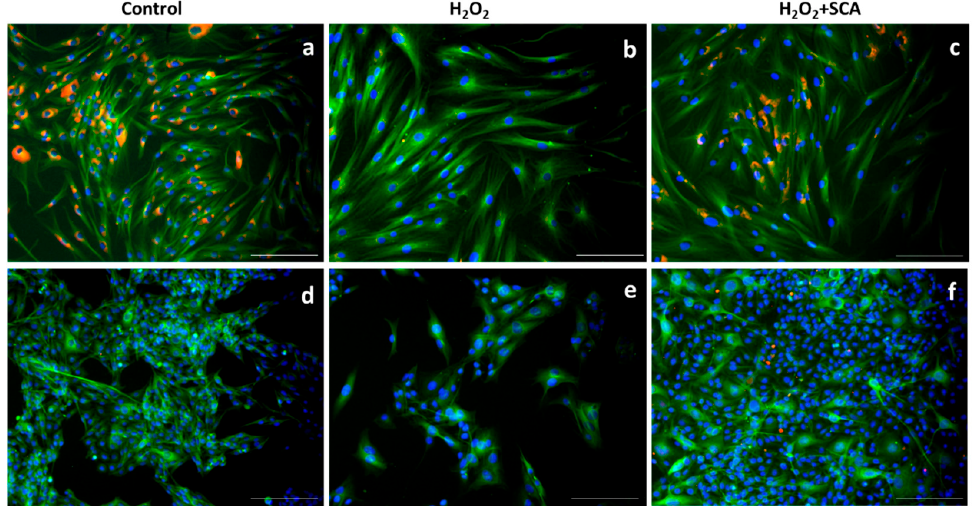
Figure 8. SCA ® treatment promoted procollagen-1 production. Representative inverted fluorescence microscopy images immunostained with anti-procollagen antibody in red, localized mainly at perinuclear level. Green color indicates cytoskeleton staining with anti-a-tubulin, and nuclei were stained blue with Hoechst probe. Fibroblasts ( a – c ) and B16–F10 cells ( d – f ) exposed to H 2 O 2 ( b , e ) and H 2 O 2 -exposed cells and treated with SCA ® ( c , f ). Scale bars: 200 µm.